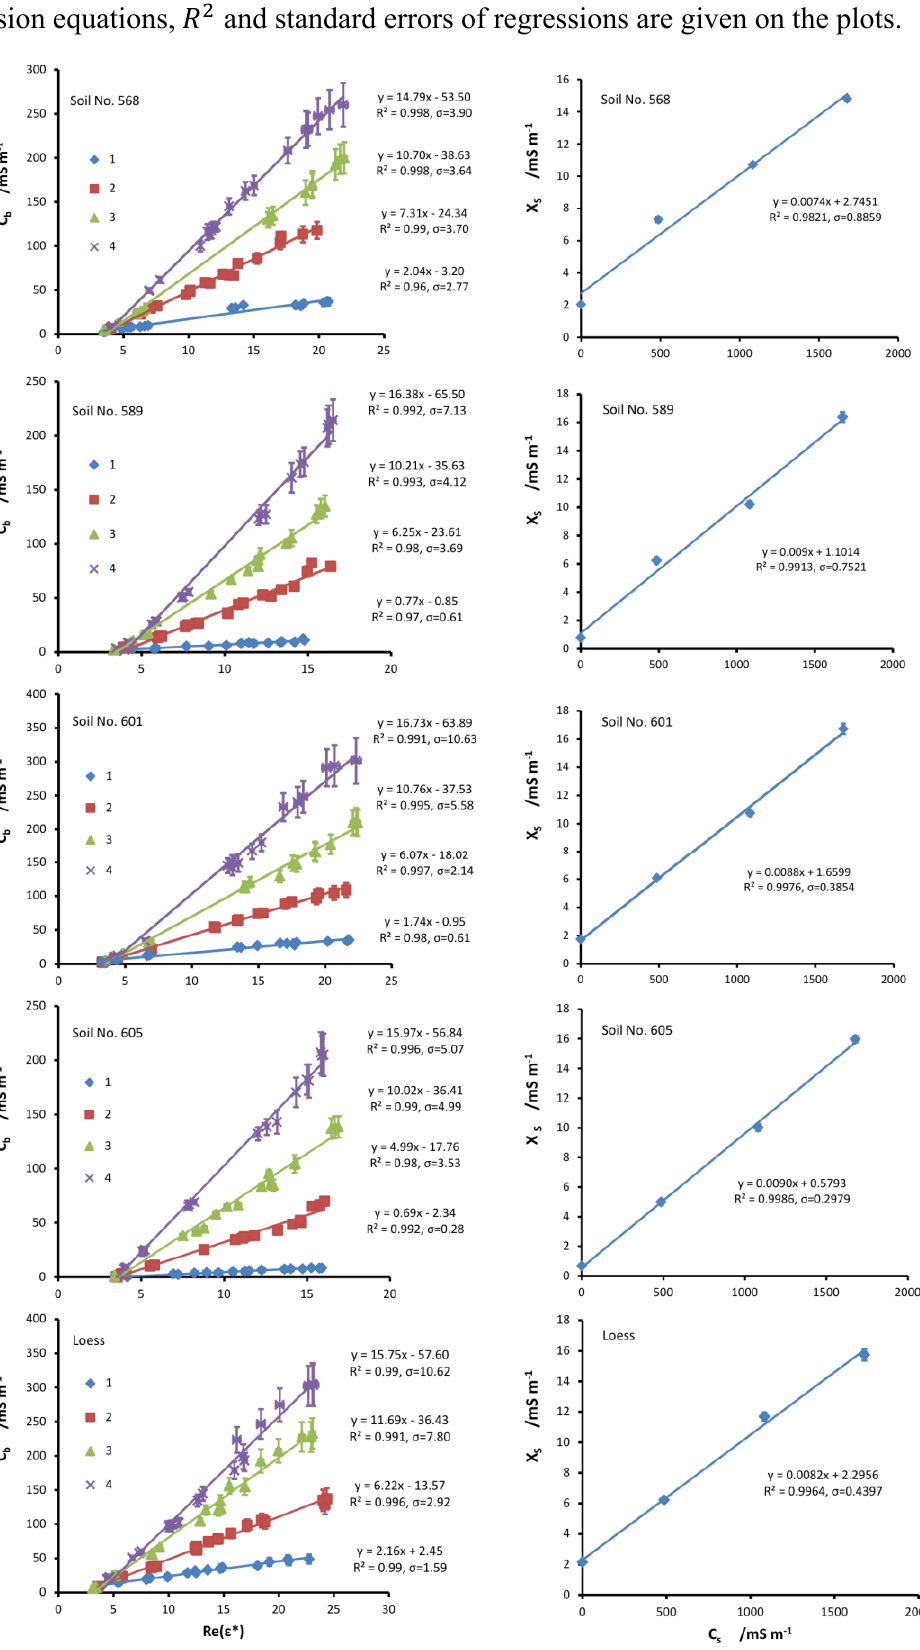
calculated as a slope of a (cid:3020) . (cid:3046)